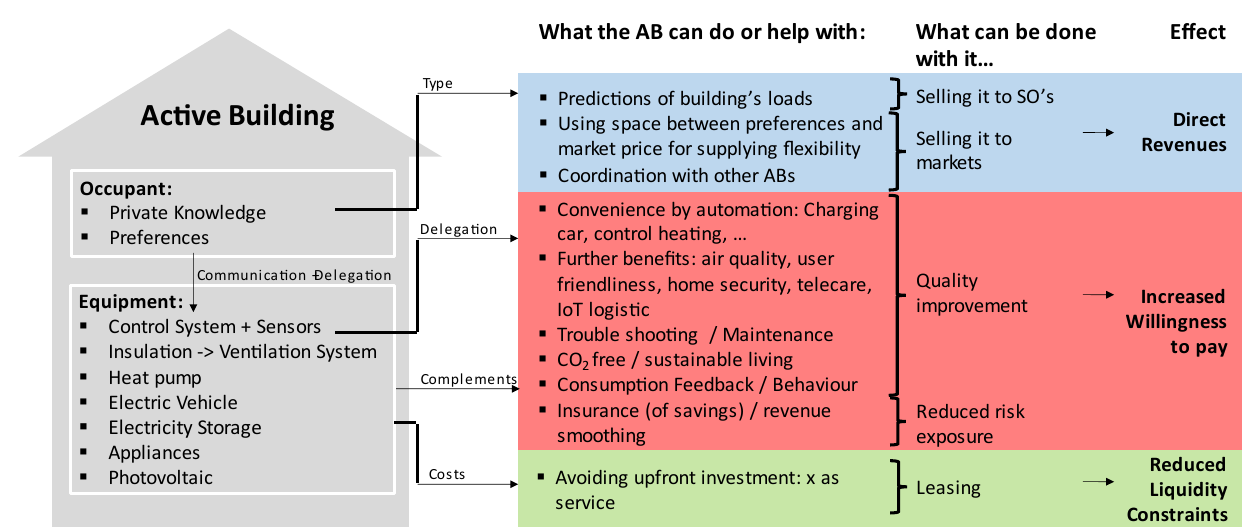
Figure 1. Active Buildings: what they can do or help with and what can be done with it.